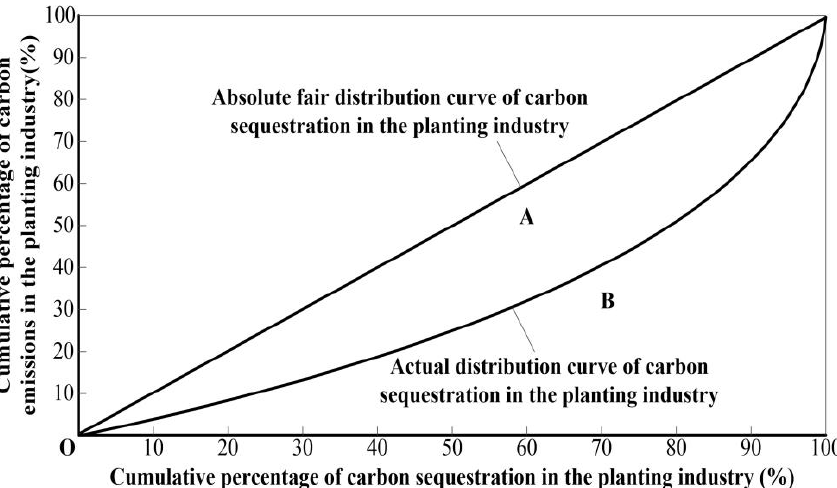
Figure 3. Lorentz curve diagram of net carbon sequestration .